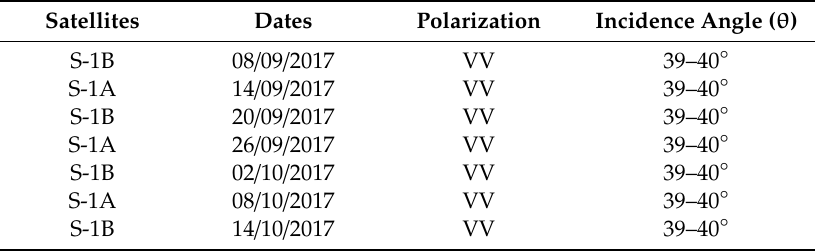
Table 1. Sentinel-1 (S-1) data acquired over the Kairouan Plain, from September 2017 until the beginning of December 2017.